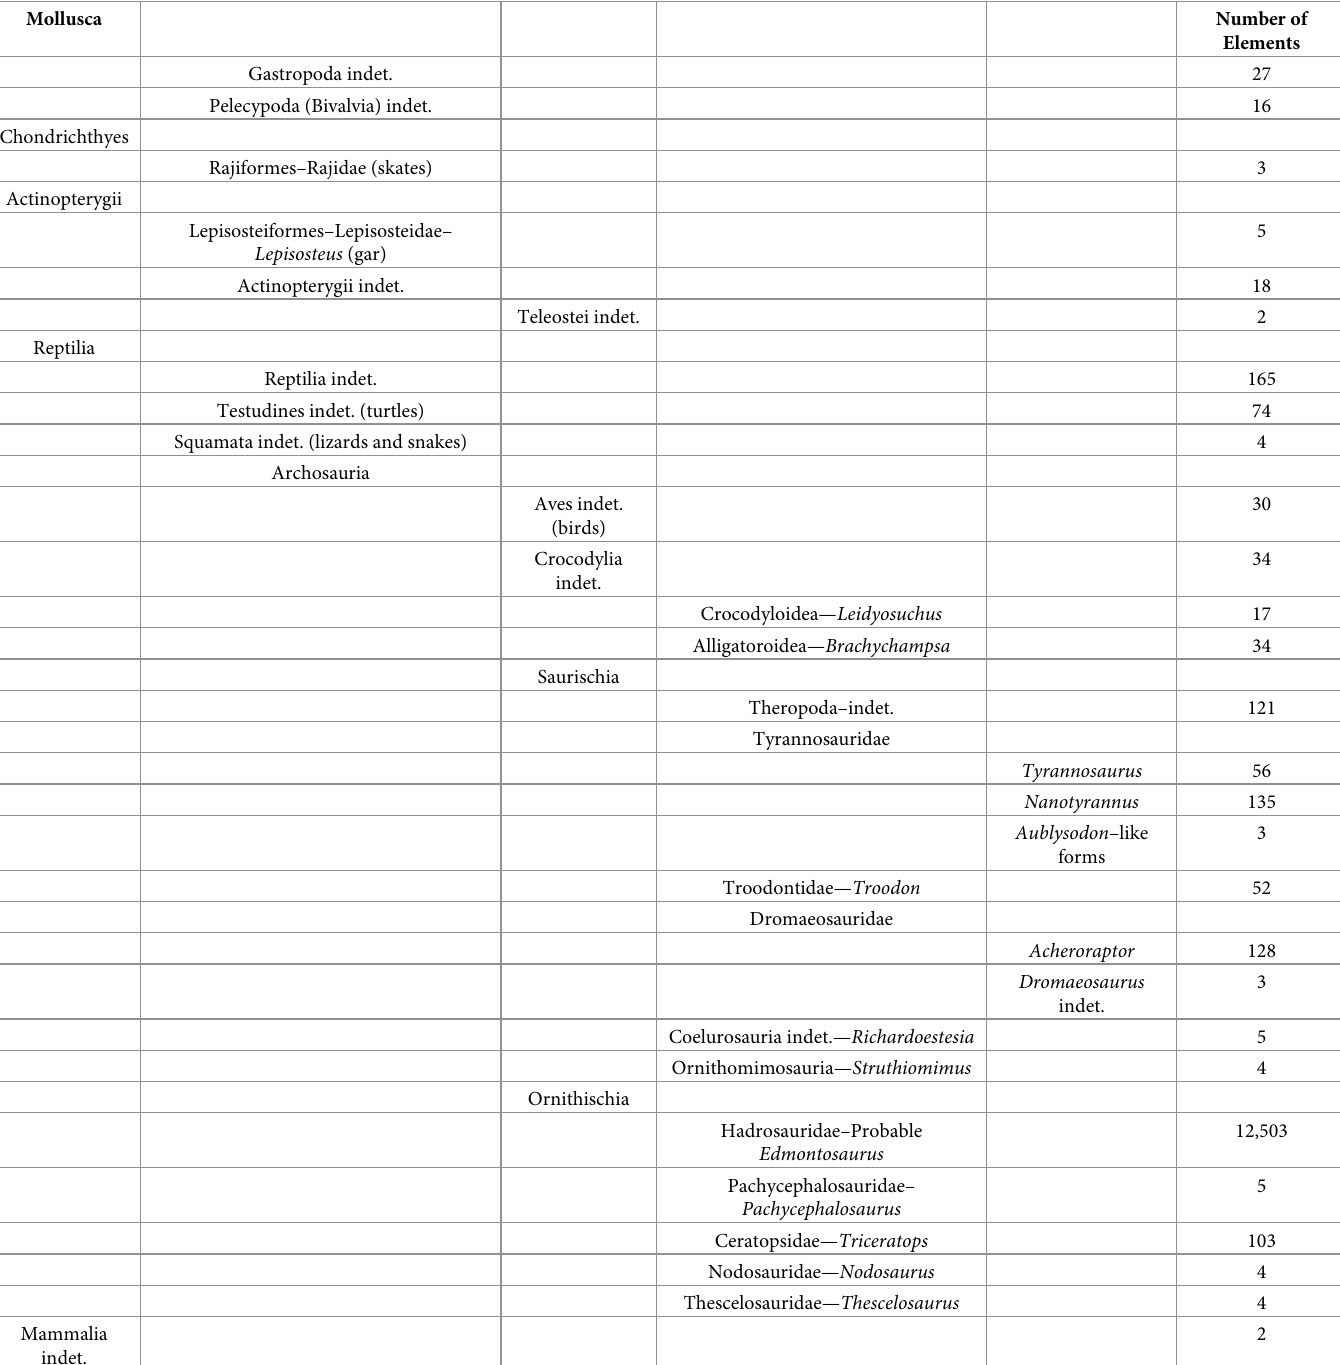
Table 2. HR Bonebed taxa represented. Nanotyrannus designation based on Larson [37]. Mollusca Gastropoda